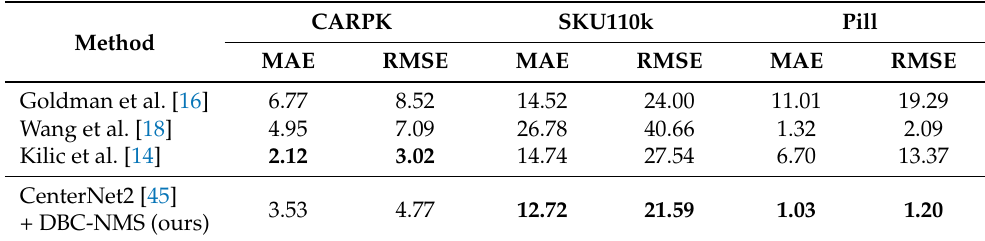
Table 2. Count task comparisons with existing